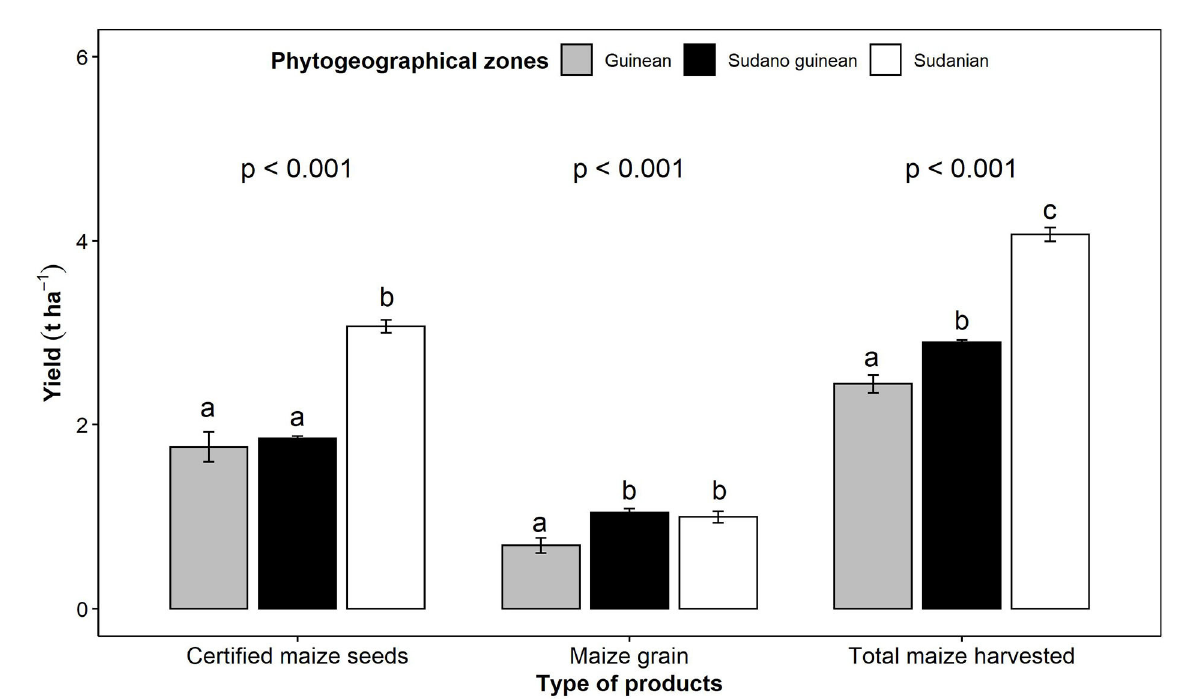
FIGURE6 Maize certified seed yields across the phytogeographical zones of Benin. Values followed by the same letter are statistically identical according to Dunn’s post-hoc test at the 0.05 probability